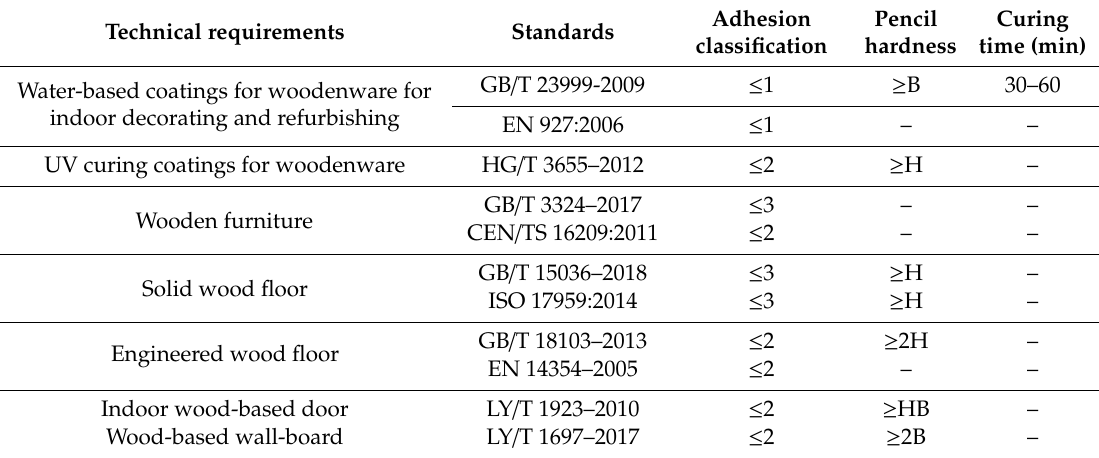
Table 3. Technical requirements for coatings and the related wooden